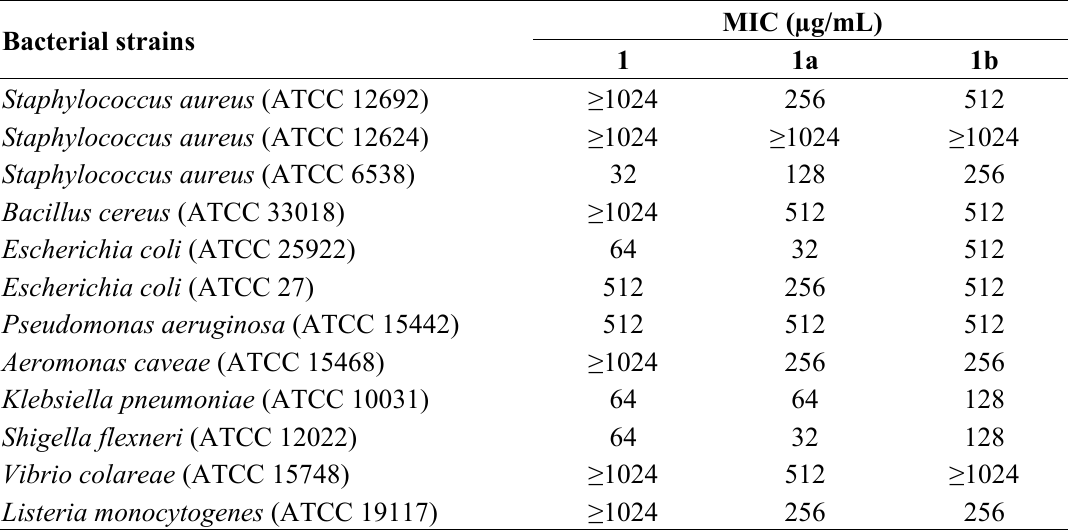
MIC (µg/mL) 1 1a 1b